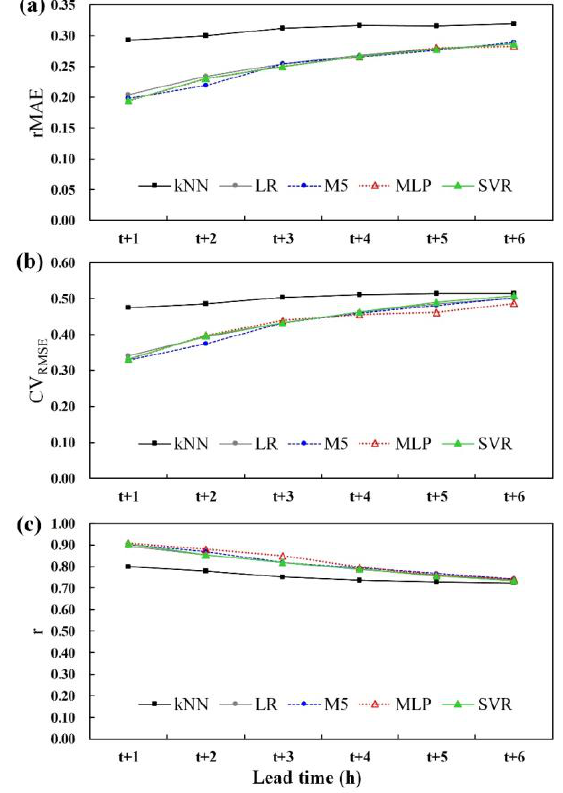
Figure 12. Performance measures at lead time from 1 h to 6 h using TV90 case: ( a ) rMAE, ( b ) CV RMSE , and ( c )